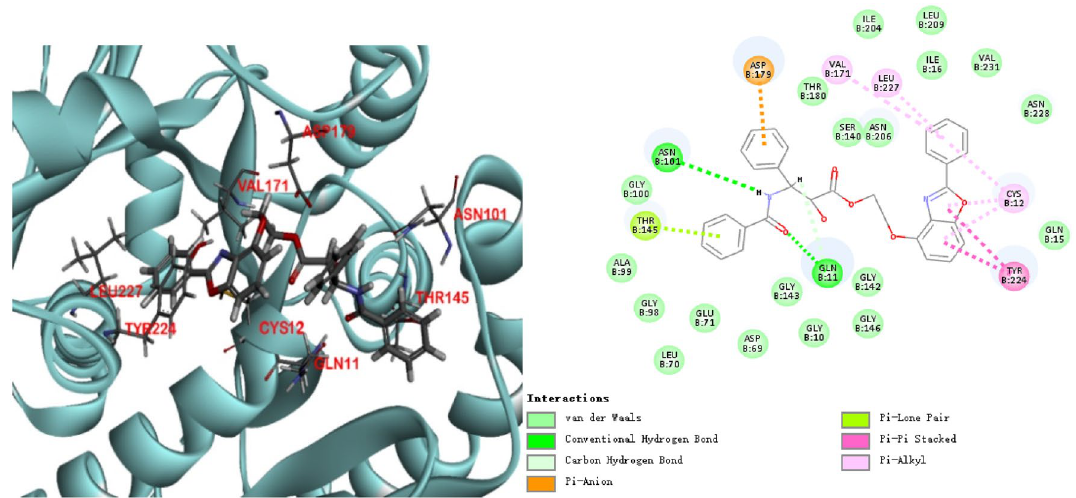
Figure 3. The molecular docking result and pattern of compound 7a and beta-tubulin.